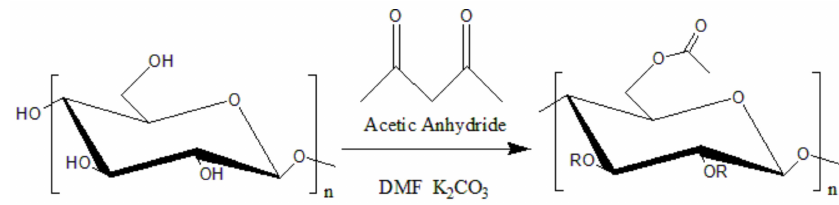
Figure 3. Acetylation modification of